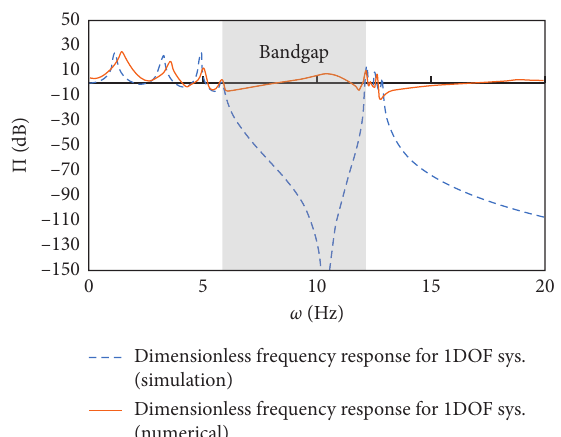
Figure 11: FRA for 1DOF model, comparison of numerical solution (MATLAB/Simulink) with simulation